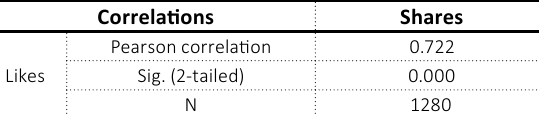
Table 3. Multicollinearity test